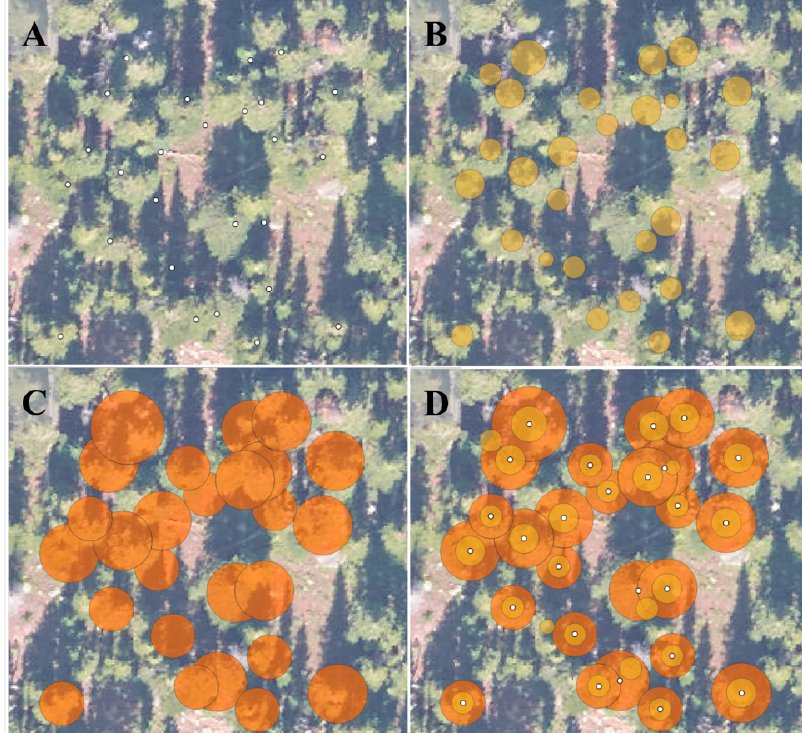
Figure 5. “Clipped” reference data sets generated using the proposed preprocessing workflow to filter out small tree crowns and clip overlapping crowns to preserve taller trees at the NIWO_015 distributed based plot: ( A ) Tree stem points corresponding to the clipped half-diameter polygons. ( B ) Clipped half-diameter polygons. ( C ) Clipped maximum-diameter polygons. ( D ) All of these points and polygons are displayed together. Polygons are displayed with 50% opacity to help illustrate the areas of overlap between adjacent polygons. Note that there is no longer overlap between adjacent polygons, and multi-bole entries have been removed. The base layer is RGB image data collected by the AOP with 0.1 m spatial